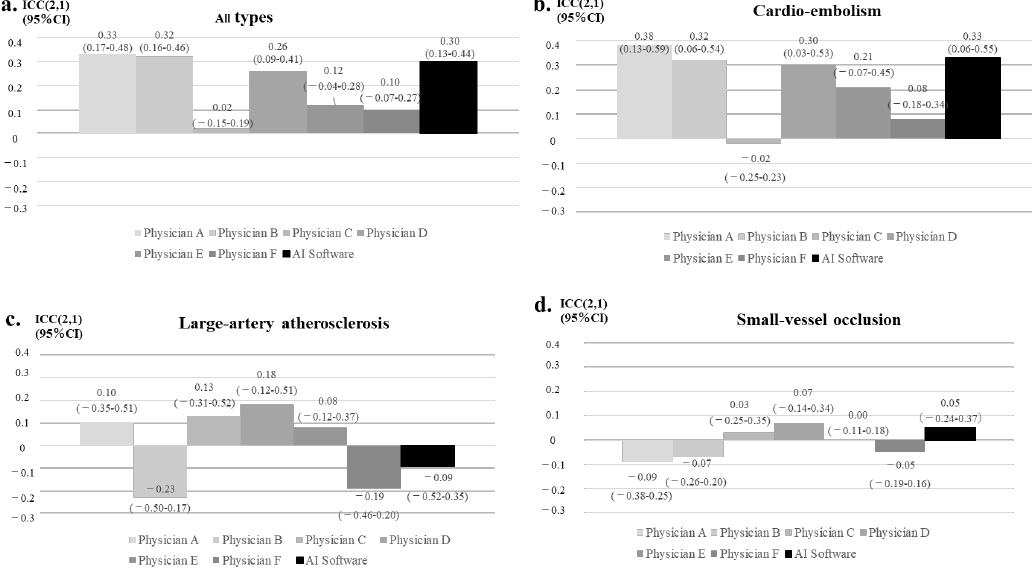
Figure 4. Reading accuracies of the AI software and neurologists in patients who had undergone CT images within 4.5 h from onset. The reading accuracies of the AI software and neurologists against the BS criteria for all types of ischemic stroke patients ( a ), for cardio-embolism ( b ), for large-artery atherosclerosis ( c ), and for small-vessel occlusion ( d ). The type of physician is shown on X axis; board-certified vascular neurologists (physicians A and B), neurology fellows (physicians C and D), and neurology residents (physicians E and F). Inter-assessor reliability of the total ASPECTS is shown in Y axis.